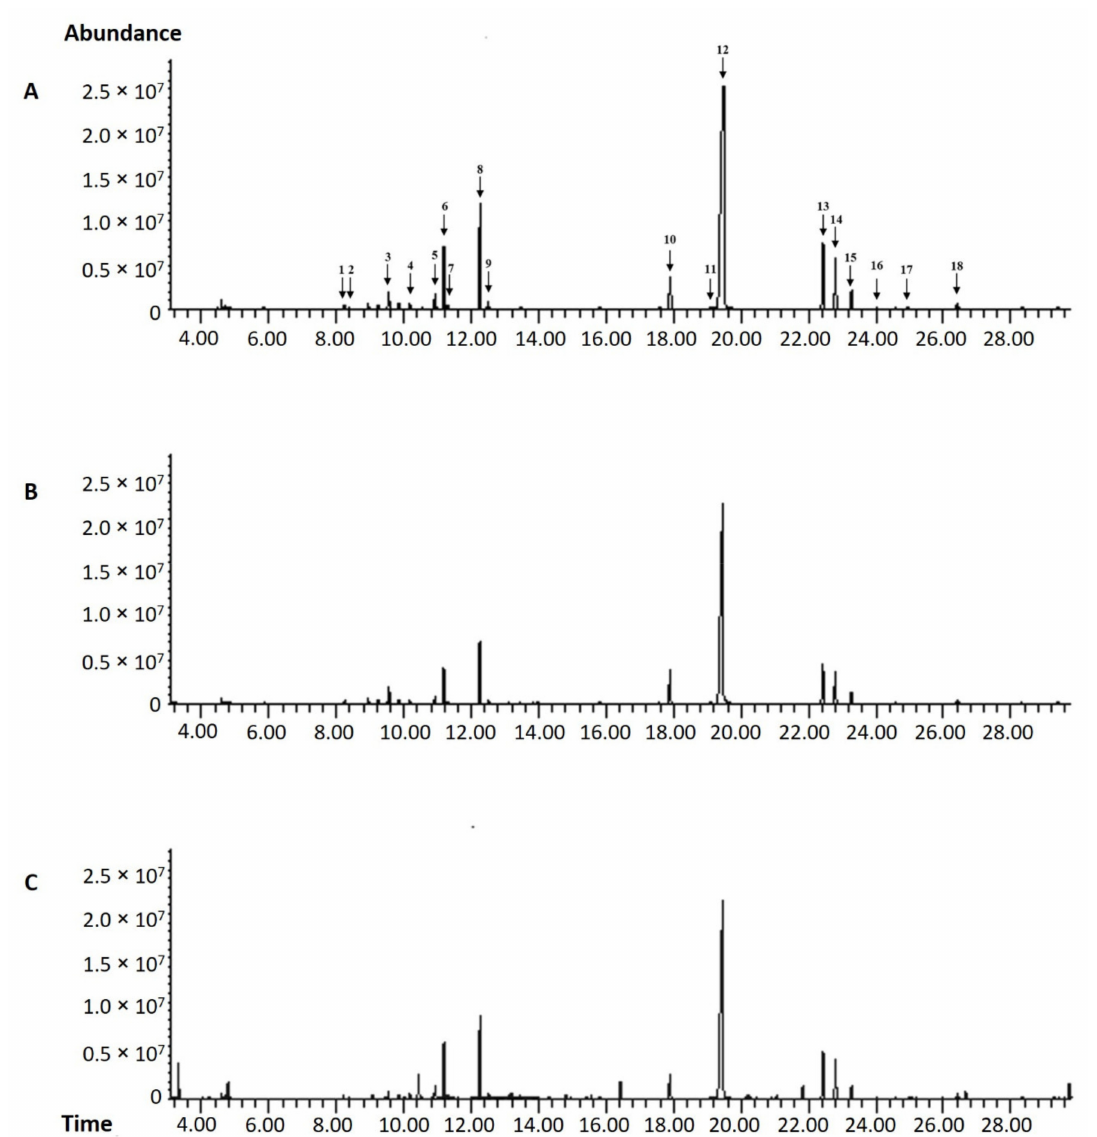
Figure 6. Chromatographic profiles of Plectranthus amboinicus essential oil extracted from leaves harvested at different time points. ( A ) 8 a.m.; ( B ) 2 p.m., and ( C ) 8 p.m. The numbers (as indicated by the black arrow) correspond to the terpenoids detected as described in Table